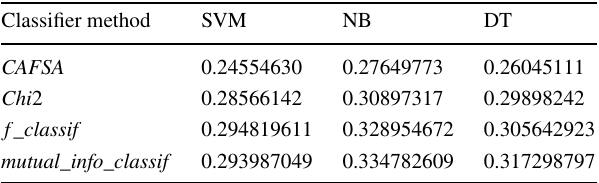
Table 6 Classic feature selection method and CAFSA experimental results on SoGouCS news data set